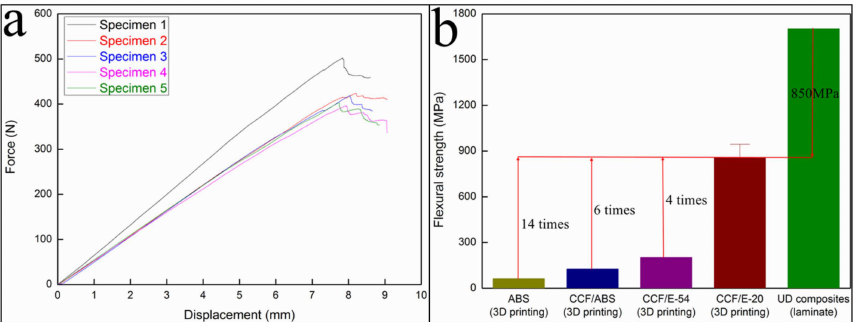
Figure 13. Flexural characterization: ( a ) the force-displacement curves and ( b ) flexural strengths of di ff erent